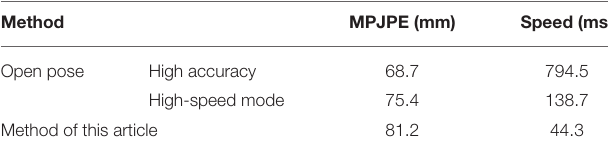
TABLE 2 | Performance and speed comparison among the proposed algorithm and other